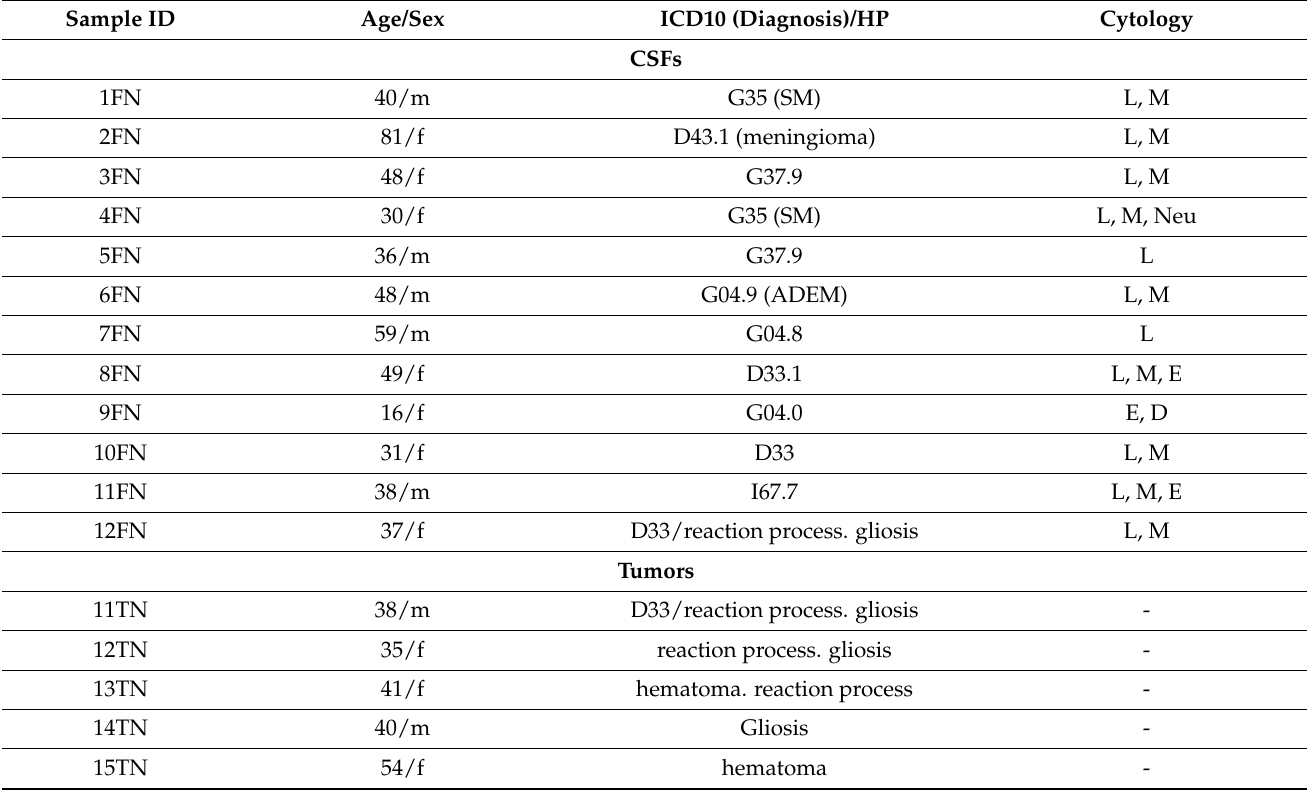
Table 2. Pathomorphological characteristics of samples from patients with non-malignant CNS diseases. Cerebrospinal fluid (FN, fluid non-malignant), n = 12; tumor (TN, tumor non-malignant), n =